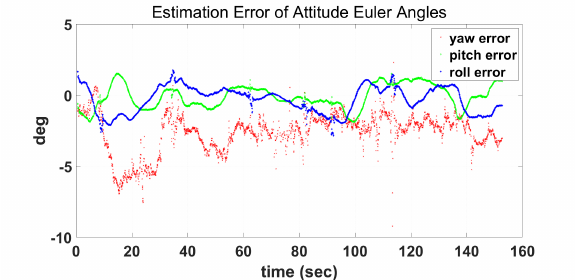
Figure 4. The attitude estimation error for the home1